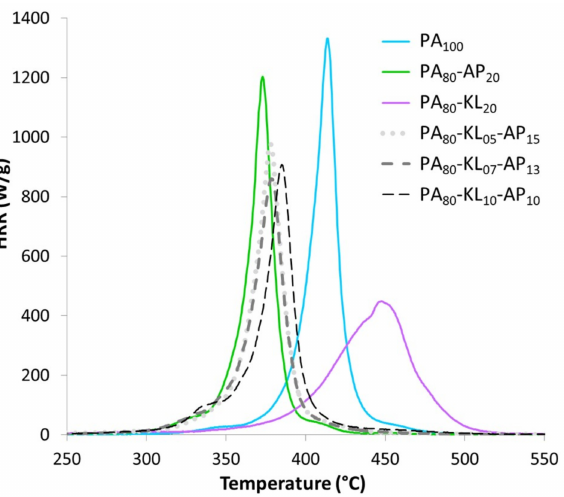
Figure 6. Curves of heat release rate (HRR) from PCFC experiments for PA blends with AP and